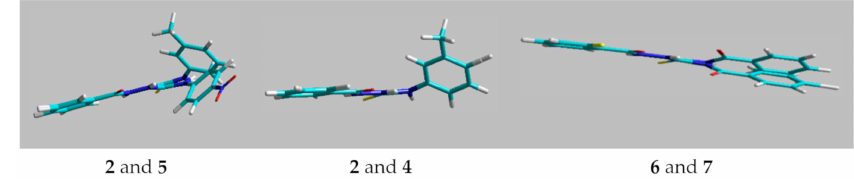
Figure 1. Overlay of structures of the 4-benzoylthiosemicarbazides 2 , 4 , 5 , and 4-arylthiosemicarbazides 6 and 7 . Note: The geometry of 1 is superimposable with 5 , whereas the geometry of 3 is superimposable with 2 and 4 . The geometries of 8 and 9 are superimposable with 6 .